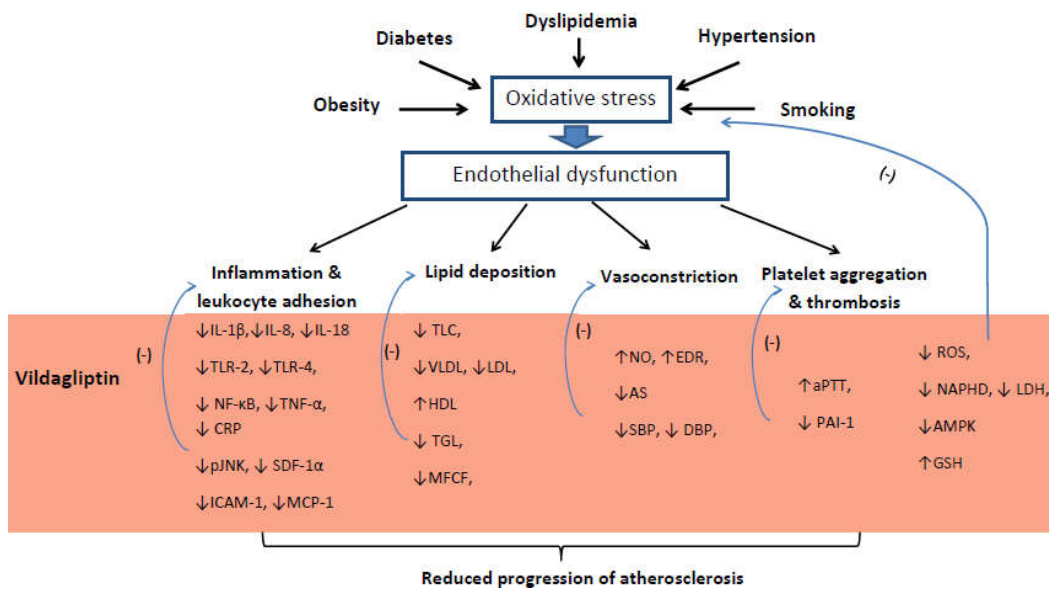
Figure 1. Proposed influence of vildagliptin on atherosclerosis pathophysiology. Note: ↓ = reduction, ↑ = increase, (-) = inhibition, IL-1β = Interleukin 1 beta, IL-8 = Interleukin 8, IL-18 = Interleukin 18, TLR2 = Toll-like receptor 2, TLR4 = Toll-like receptor 4, NF-κB = nuclear factor kappa-light-chain-enhancer of activated B cells, TNF-α = tumor necrosis factor α, CRP = C-reactive protein, pJNK = phosphorylated c-Jun N-terminal kinase, SDF-1α = stromal cell-derived factor 1, ICAM-1 = intercellular adhesion molecule 1, MCP-1 = Monocyte chemoattractant protein-1, TLC = total cholesterol level, VLDL = very low density lipoprotein, LDL = low density lipoprotein, HDL = high density lipoprotein, TGC = triglycerides, MFCF = macrophages foam cells formation, NO = nitric oxide, EDR = endothelial-dependent relaxation, AS – arterial stiffness, SBP = systolic blood pressure, DBP = diastolic blood pressure, aPTT = activated partial thromboplastin time, PAI-1 = plasminogen activator inhibitor-1, ROS = reactive oxygen species, NADPH = Nicotinamide adenine dinucleotide phosphate, LDH = lactate dehydrogenase, AMPK = 5’AMP-activated protein kinase, GSH = glutathione.